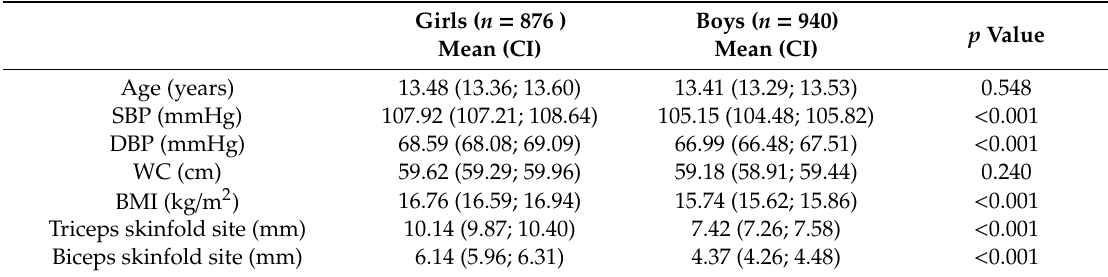
Table 1. Characteristics of the participants by gender.